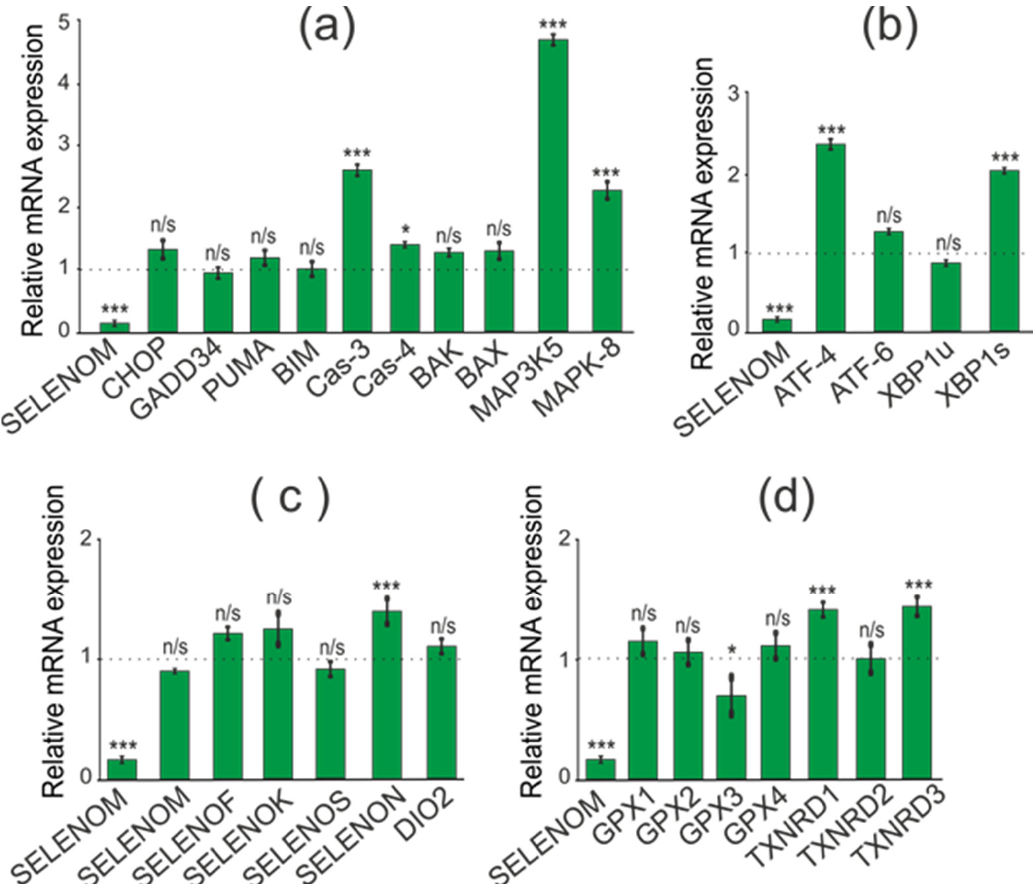
Figure 9. Comparative analysis of mRNA expression patterns of various genes under SELENOM-KD after 24 h treatment of A-172 cells with 5 µg/mL SeNP, obtained using real-time PCR. ( a ) mRNA expression of pro-apoptotic genes; ( b ) mRNA expression of three UPR signaling pathways markers; ( c ) mRNA expression of ER resident selenoproteins; ( d ) mRNA expression of selenium-containing glutathione peroxidases and thioredoxin reductases. Comparison of experimental groups regarding control, indicated as dash line (1): n/s—data not significant ( p > 0.05), * p < 0.05 and *** p < 0.001.